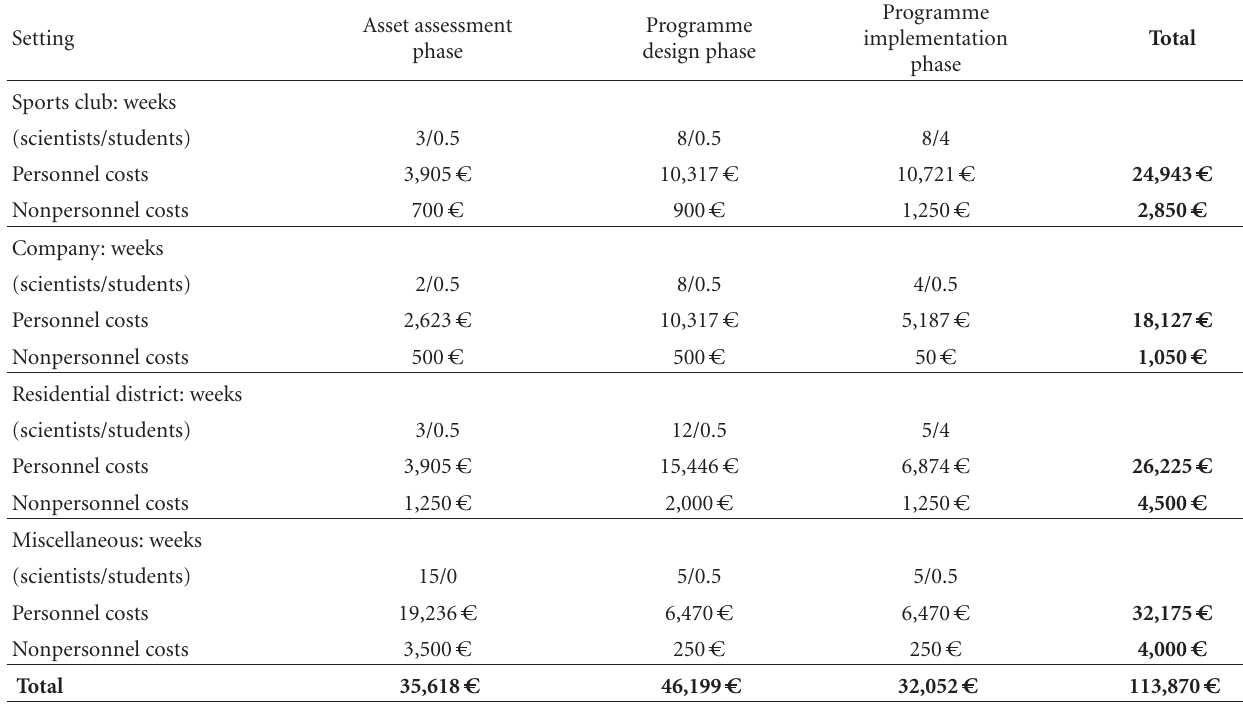
Table 5: Working time and total personnel and nonpersonnel costs of scientists by setting and project